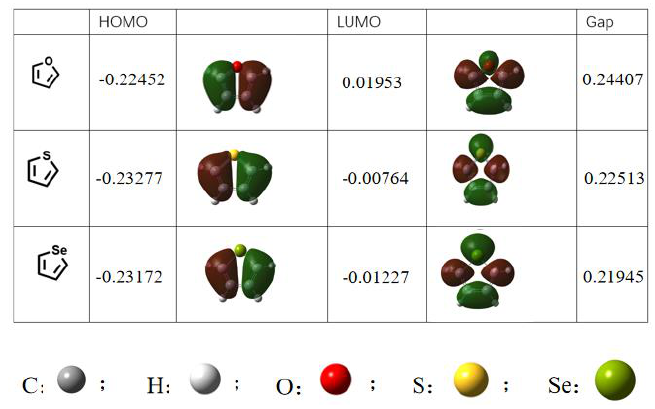
Figure 2. DFT for furan, thiophene, and